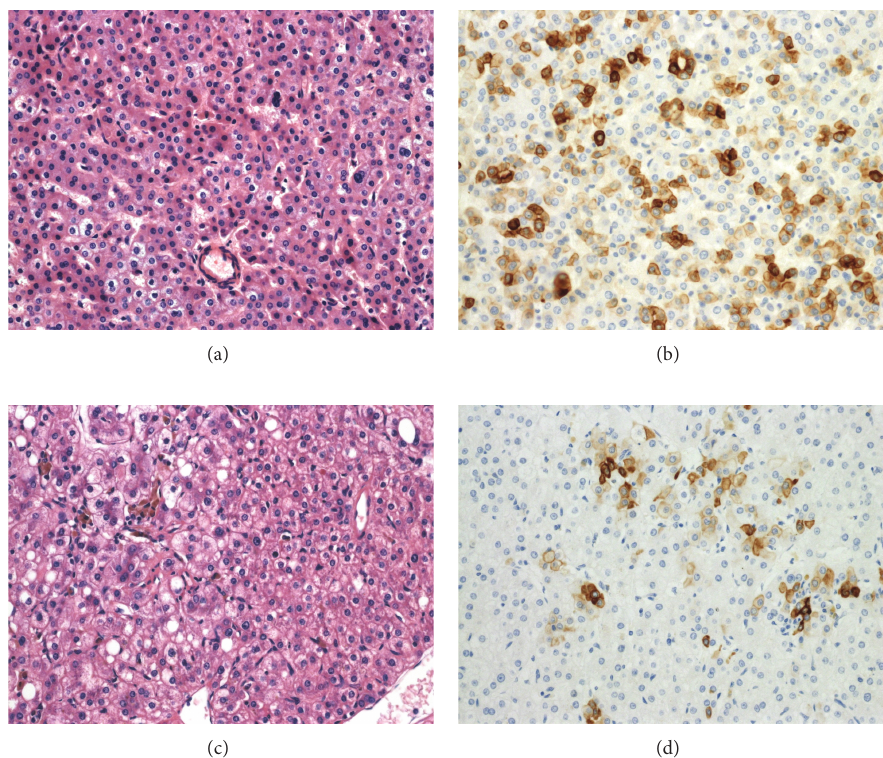
Figure 4: Unclassified HCA (a) with numerous small hepatocytes expressing CK7 (b). Unclassified HCA with worrisome nuclear atypia (c) with numerous small hepatocytes expressing CK7 (d). (Obj ×